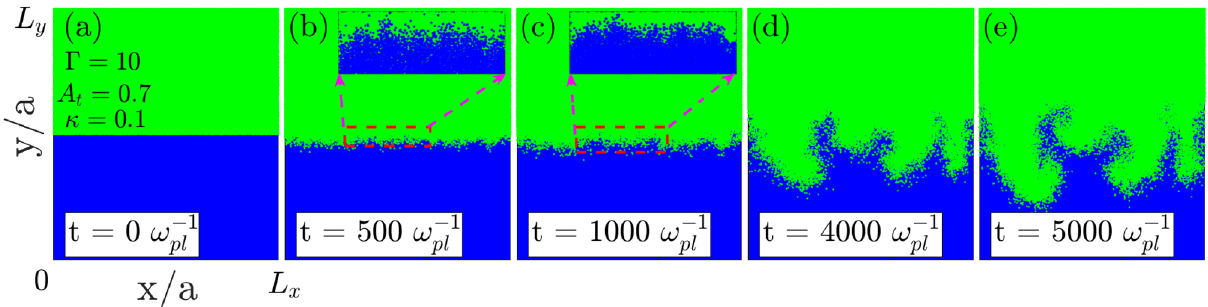
1 pl , is unstable towards the RTI under 1 pl , respectively.